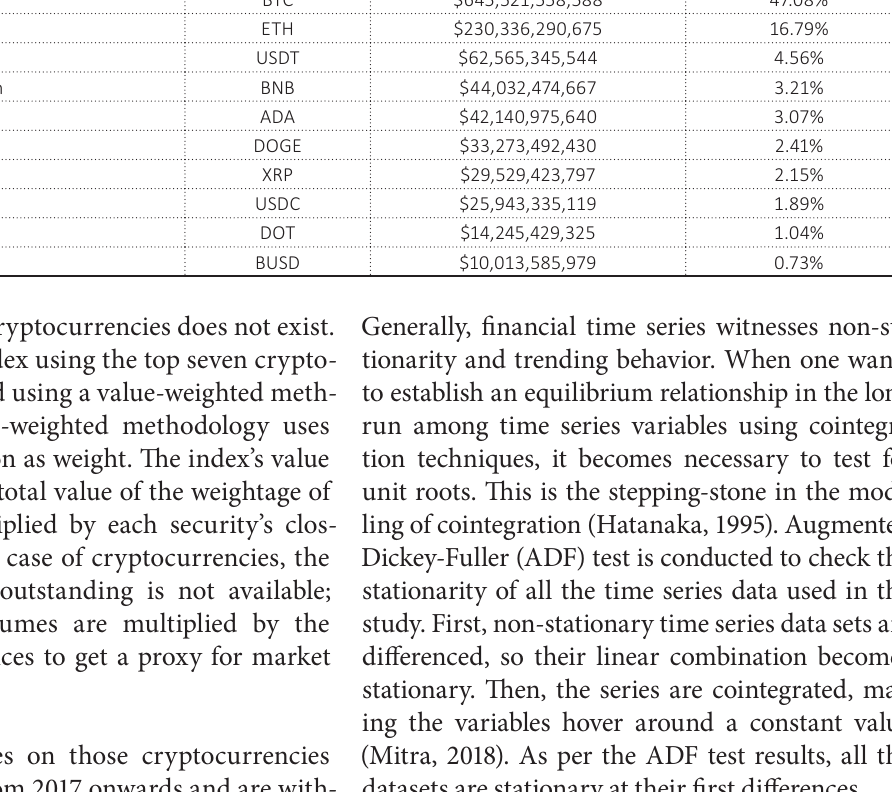
Table 1. Top traded cryptocurrencies Source: Author’s calculations, using https://coinmarketcap.com/. As of June 28, 2021, the market cap of cryptocurrency is 1.37 trillion. S.